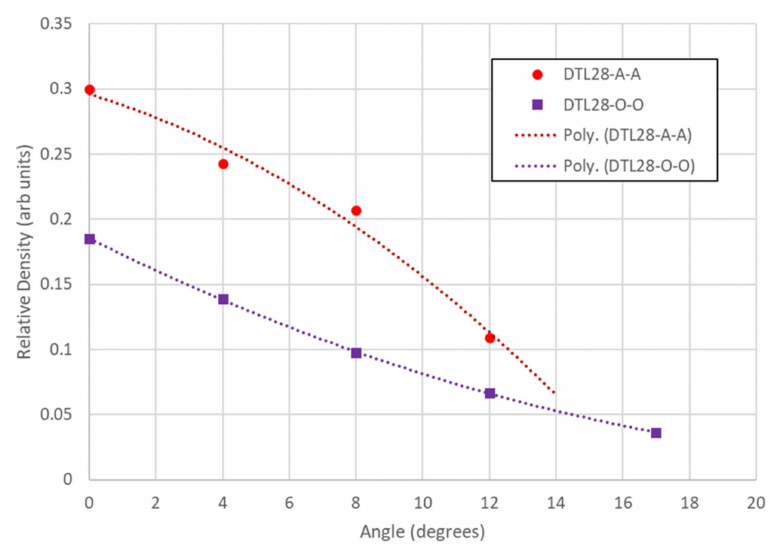
Figure 12. Relative molybdenum density profiles for high and low utilization